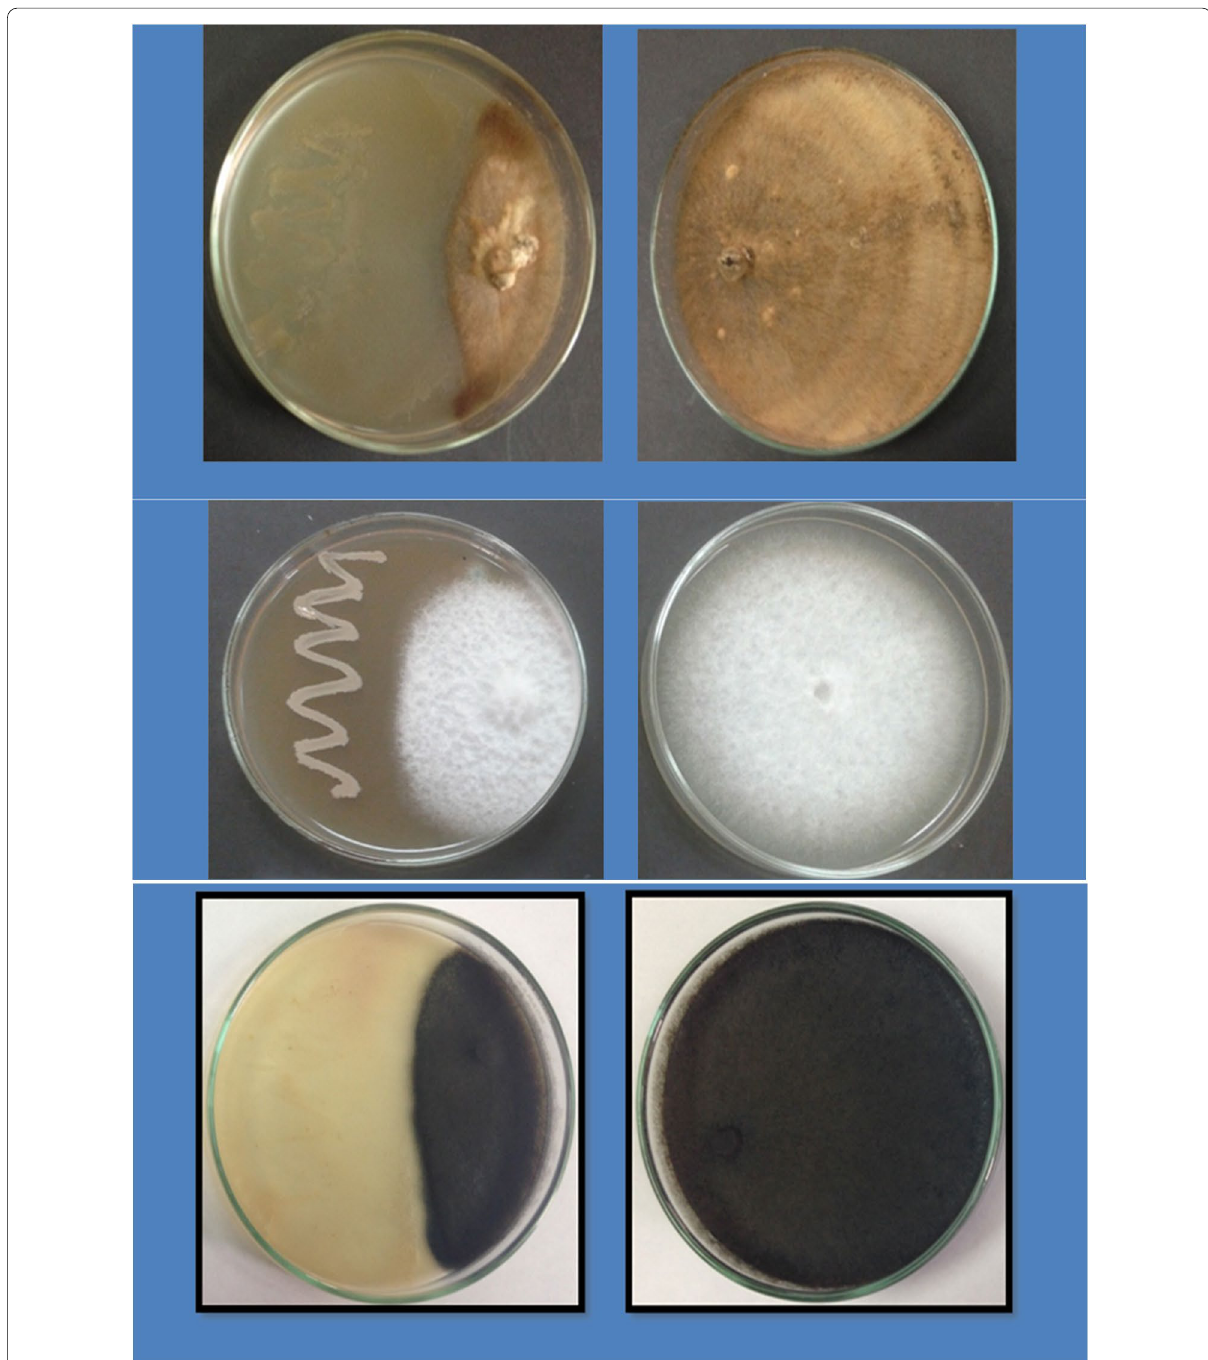
Fig. 2 Effect of Paenibacillus polymyxa isolate 1 on growth area of the pathogenic fungi Macrophomina phaseolina (upper dishes), Rhizoctonia solani (Medium dishes), and Fusarium solani (lower